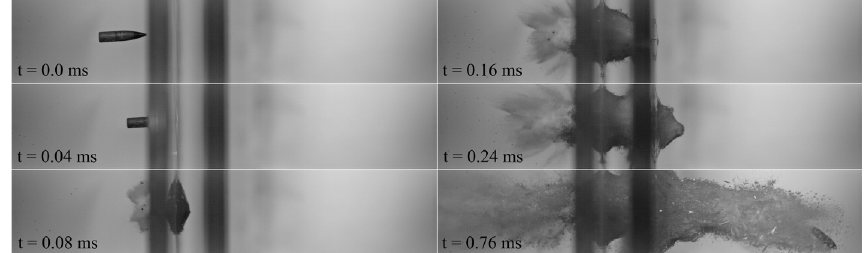
Fig. 2. High-speed camera images of DLx2-2 where v i = 522.8 m/s and v r = 240.6 m/s. The velocity between plates is estimated as v = 412.8 m/s.